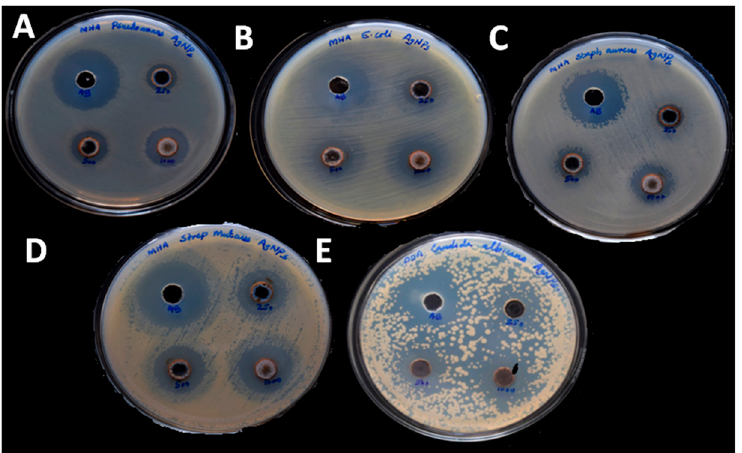
Figure 5. Antimicrobial activity of AgNPs against: ( A ) Pseudomonas aeruginosa ( B ) Escherichiacoli ( C ) Staphylococcusaureus ( D ) Streptococcus mutans ( E ) Candida albicans